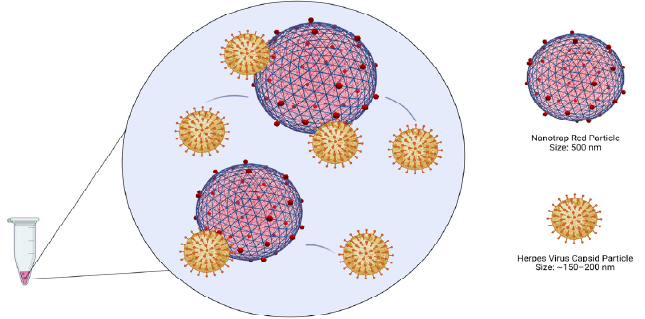
Figure 2. Binding of herpesviruses to the Nanotrap Red particles (Created with BioRender.com).